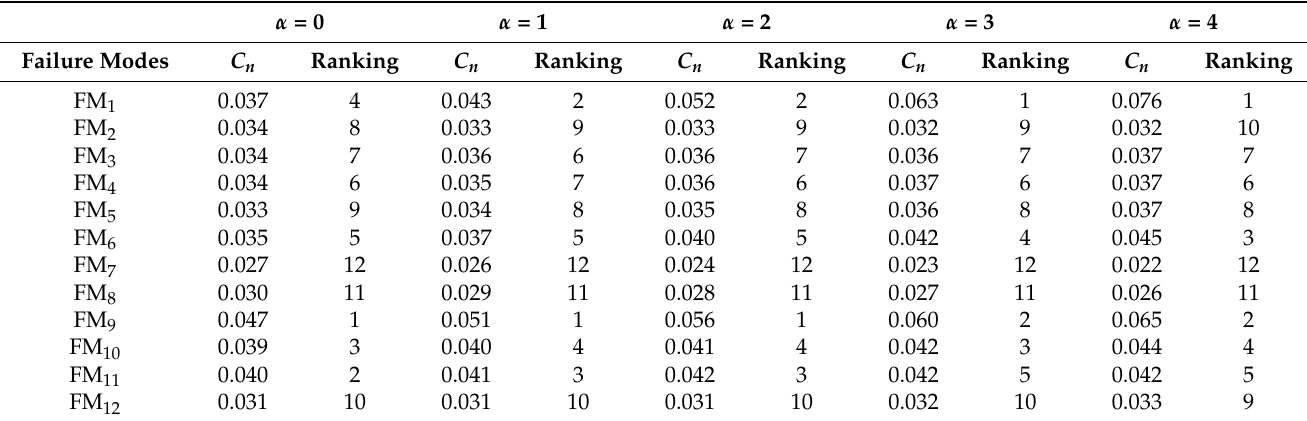
Table 11. Ranking comparison of taking different α value (Improved fuzzy TOPSIS using the subjective-variable integrated weight method).